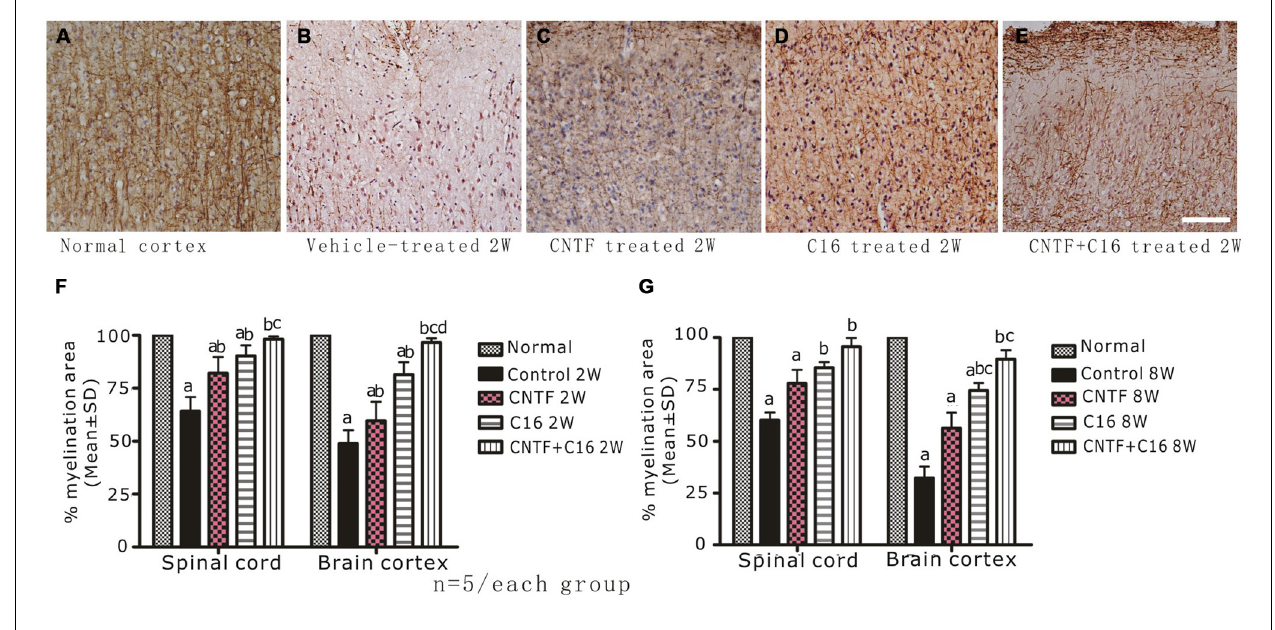
FIGURE 3 |Treatment with CNTF or C16 reduced demyelination in the spinal cord and cerebral cortex, as revealed by MBP immunostaining, counterstained with hematoxylin (coronal sections of brain motor cortex), Bar = 100 μ m. At week 2 post-immunization, normal control group (A) , vehicle-treated EAE rats (B) , CNTF-treated EAE rats (C) , C16-treated EAE